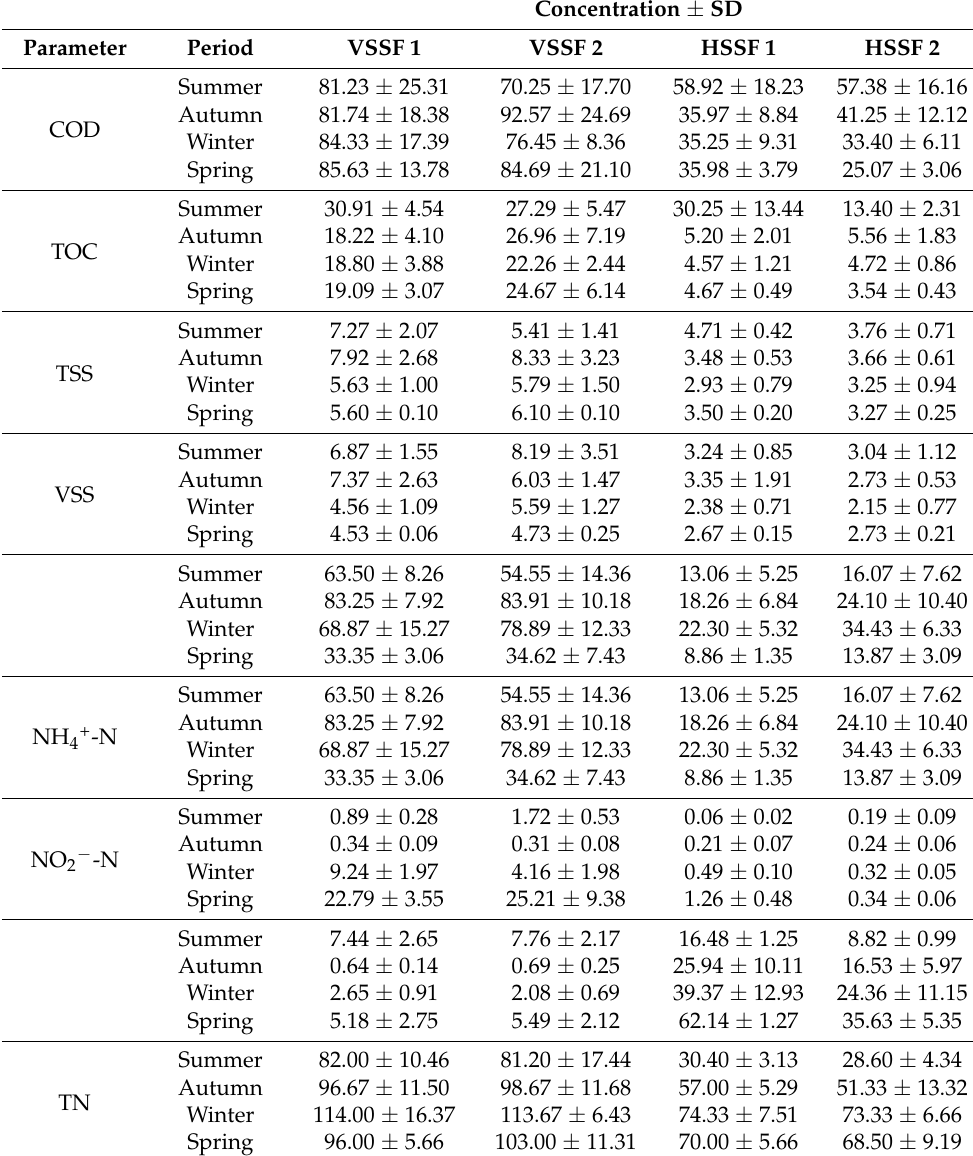
Table 3. Physicochemical characterization of the effluent for different